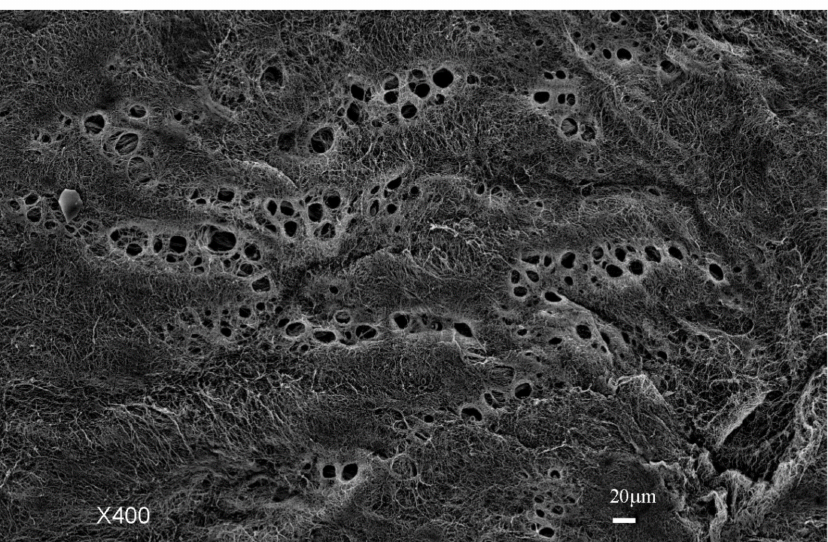
Figure 7. Collagen plate with small holes (MC). Below the submesothelail basement membrane, the MC contains multiple holes, and a blind loop of a submesohelial lymphatic vessels is attached to hole (scanning electron micrography taken after maceration by 6N KCL. The specimen is Morrison’s pouch from gastric cancer patient. Diameters of the holes of MC ranged from 30 µ m to 150 µ m.